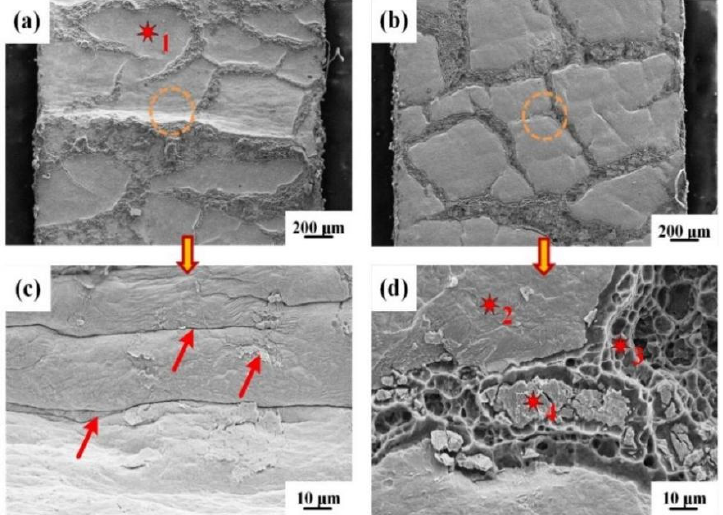
Figure 8. SEM images of Cu and Al surfaces for IFR-450 after peeling test: ( a ) Cu side, ( b ) Al side, ( c , d ) enlarged images of the circles in the ( a , b ). Table 1. Chemical composition of corresponding points at the peeling surface of IFR-450 (at. %). Points